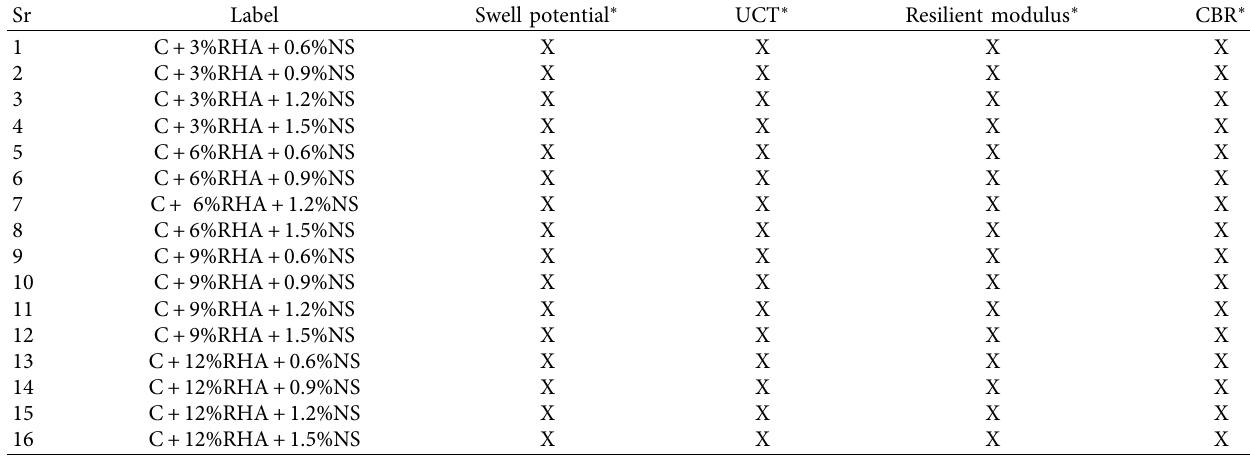
Table 3: Expansive clay, rice husk ash, and nanosilica composite tests matrix.